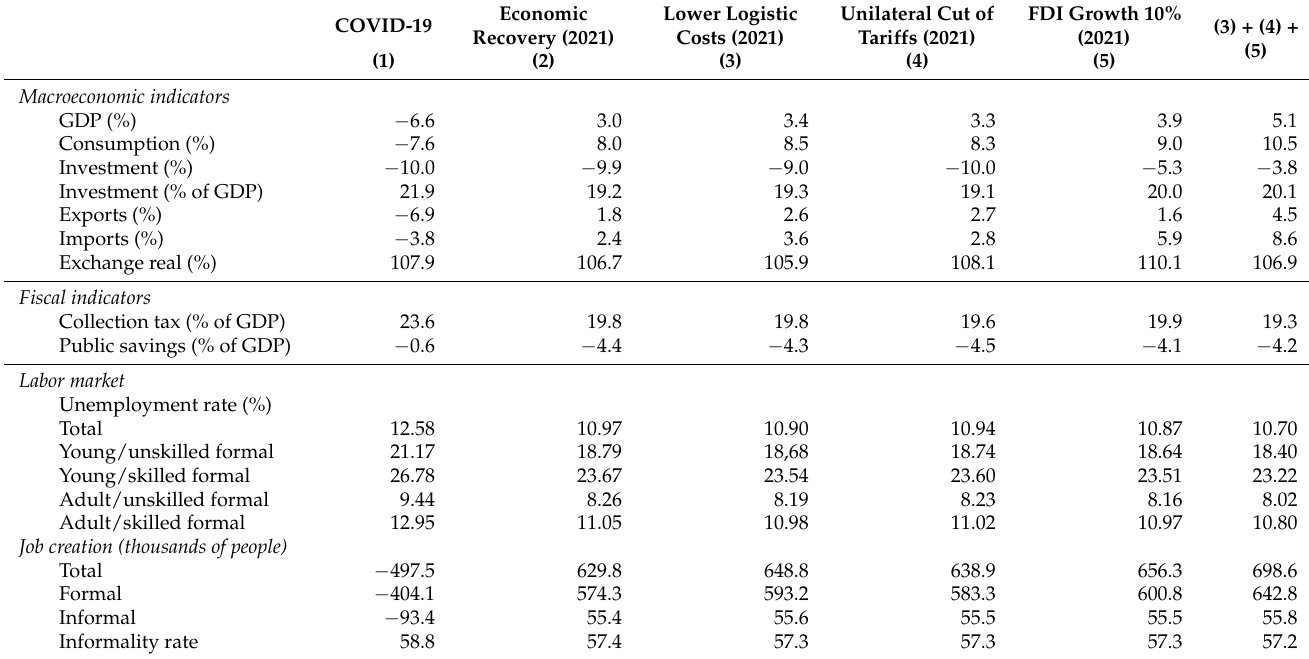
Table 4. Simulated effects of COVID-19 on aggregate indicators and labor